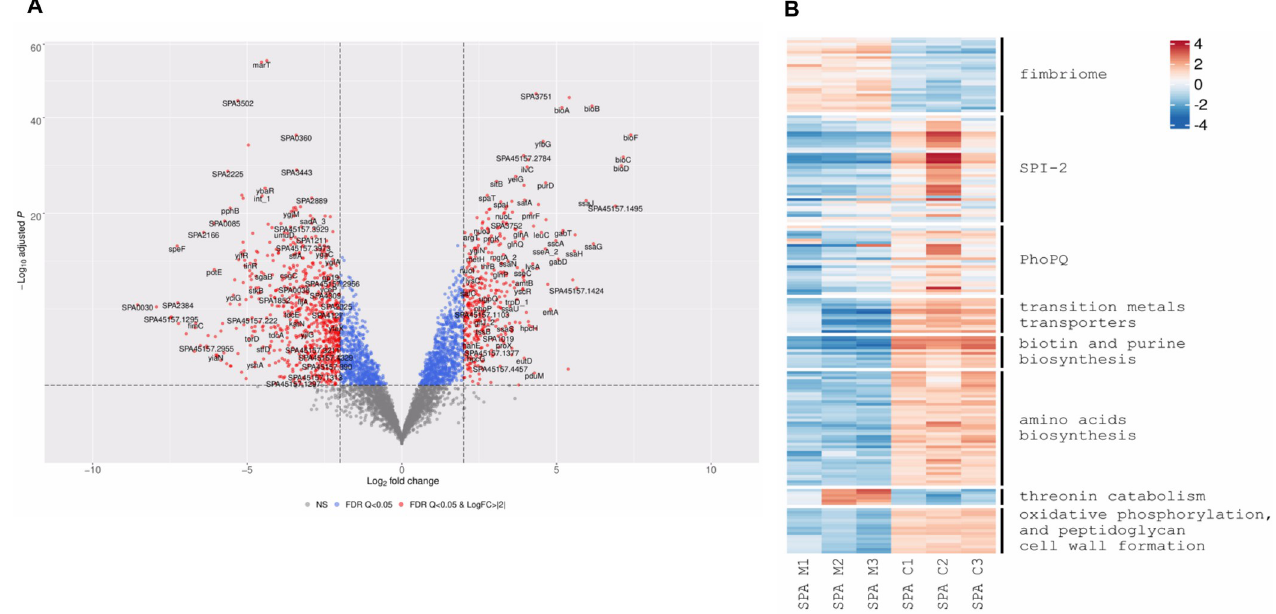
Fig 3. DEGs of intracellular S . Paratyphi A compared to growth in LB medium. (A) a volcano plot showing the fold change (log2 ratio) in the expression of SPA genes grown intracellularly in HeLa cells (8 h p.i.) vs. the growth in LB medium (X-axis) plotted against the -log 10 adjusted p-value (Y-axis). Each dot on the plot represents the mean value (from three independent cultures) of one gene. Genes that were changed by more than twofold are colored in red. ( B ) Heatmap based on RNA-Seq results showing the relative transcription of SPA genes of interest during intracellular infection (C1 to C3) vs. their extracellular expression in LB medium (M1 to